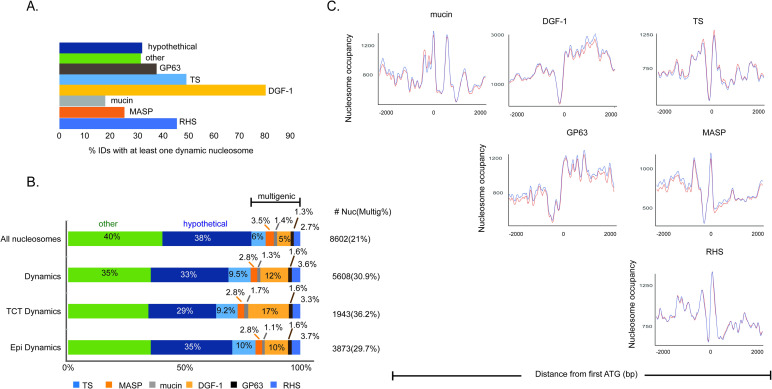
Nucleosome organization of multigenic family members.A. Percentage of the indicated genes with at least one dynamic nucleosome (FDR <0.001). B. Distribution of all nucleosomes, dynamic nucleosomes, and dynamic (increase at occupancy and/or fuzziness) nucleosomes in epimastigotes and TCTs at intragenic regions (all genes classified as “mRNA”, “pseudogenic”, “tRNA”, “snoRNA”, “snRNA”, “rRNA”). The “other” category refers to all intragenic regions except those represented here. A significant difference was observed for categories “All nucleosomes” vs “Dynamics” (p-value <0.05, chi-square test under α = 0.05 with corrected z-score = +/- 2.7 by Bonferroni), with significant positive residuals (overrepresentation on dynamic nucleosomes) for categories TS (+10.2), DGF-1 (+19.1) and RHS (+3.7), while negative residuals (underrepresentation on dynamic nucleosomes) were observed for hypothetical (-5.9) and “other” (-5.9). A significant difference was observed for categories “epimastigotes” vs “TCT” (p-value <0.05, chi-square test under α = 0.05 with corrected z-score = +/- 2.7 by Bonferroni), with significant positive residuals (overrepresentation on TCTs) for categories DGF-1 (+6.2) and negative residuals (underrepresentation on epimastigotes) for DGF-1 (-4.3). Full chi-square test residuals values are given in S3 Fig. C. Nucleosomal landscape among genes from the multigenic family for epimastigotes (red) and trypomastigotes (blue). Occupancy levels were obtained by DANPOS2 using kb ranges (at x axis) for each gene class.